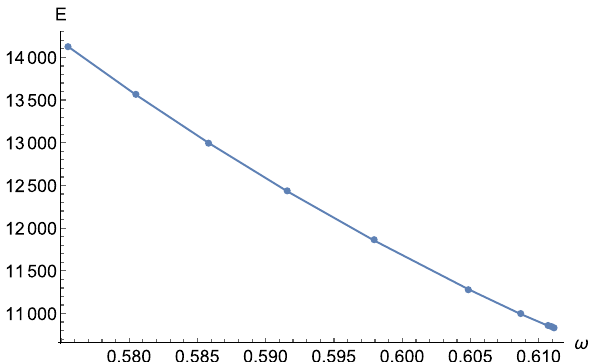
Fig. 5 Energy vs ω for the previous solution parameters at varying Q